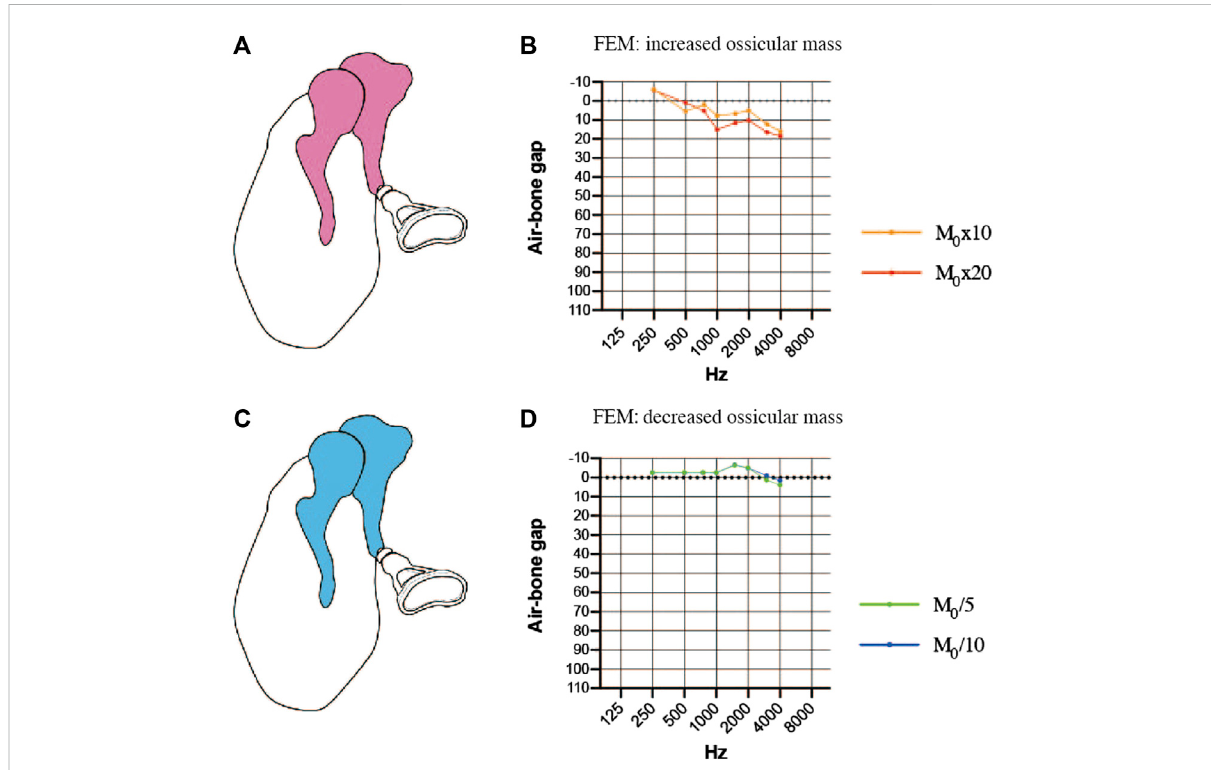
FIGURE 6 Simulated air-bone gaps (ABGs) for fi nite element models (FEMs) of altered malleus and incus mass. (A) Schematic showing an increase in the mass of the malleus and incus (pink). (B) Audiogram simulated using the FEM of increased ossicular mass. (C) Schematic showing a decrease in the mass of the malleus and incus (blue). (D) Audiogram simulated using the FEM of decreased ossicular mass. The effects of the mass change were mainlyobserved inthe1000 – 4000 Hzfrequencyrange,butthechangesintheABGwerelessthan10 dBHLfor a10-foldincrease ordecrease in mass. M 0 :